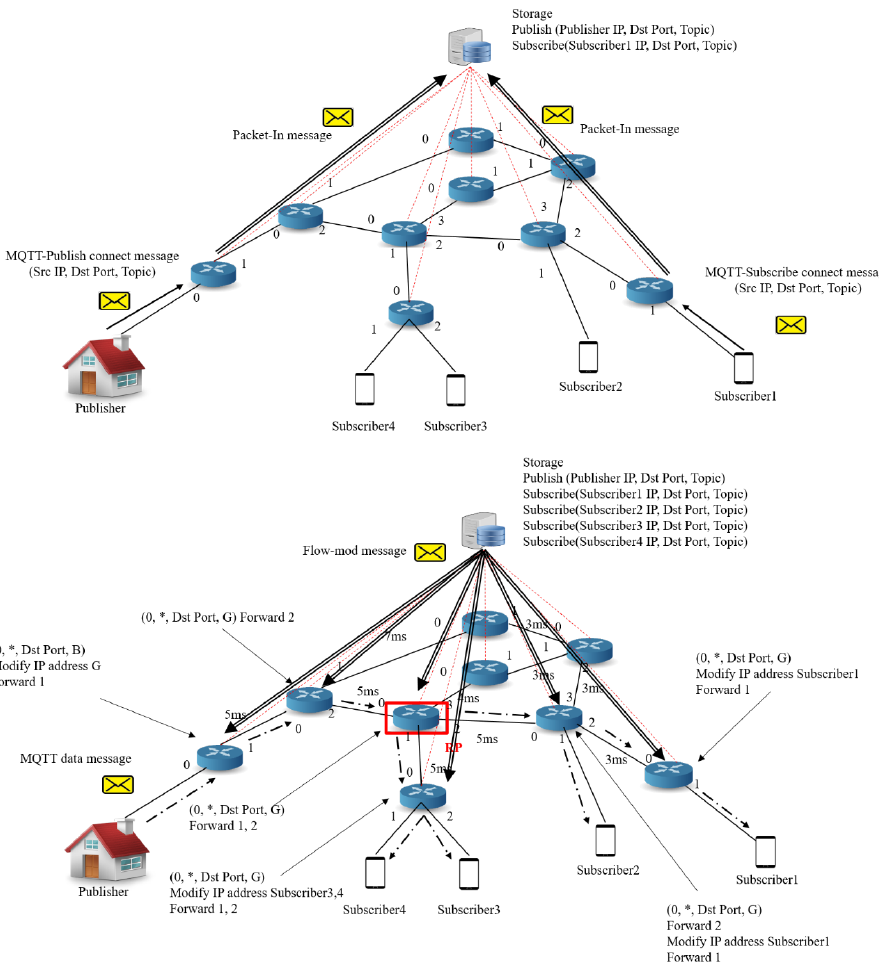
Figure 3. The two types of operation processes in DM-QTT.